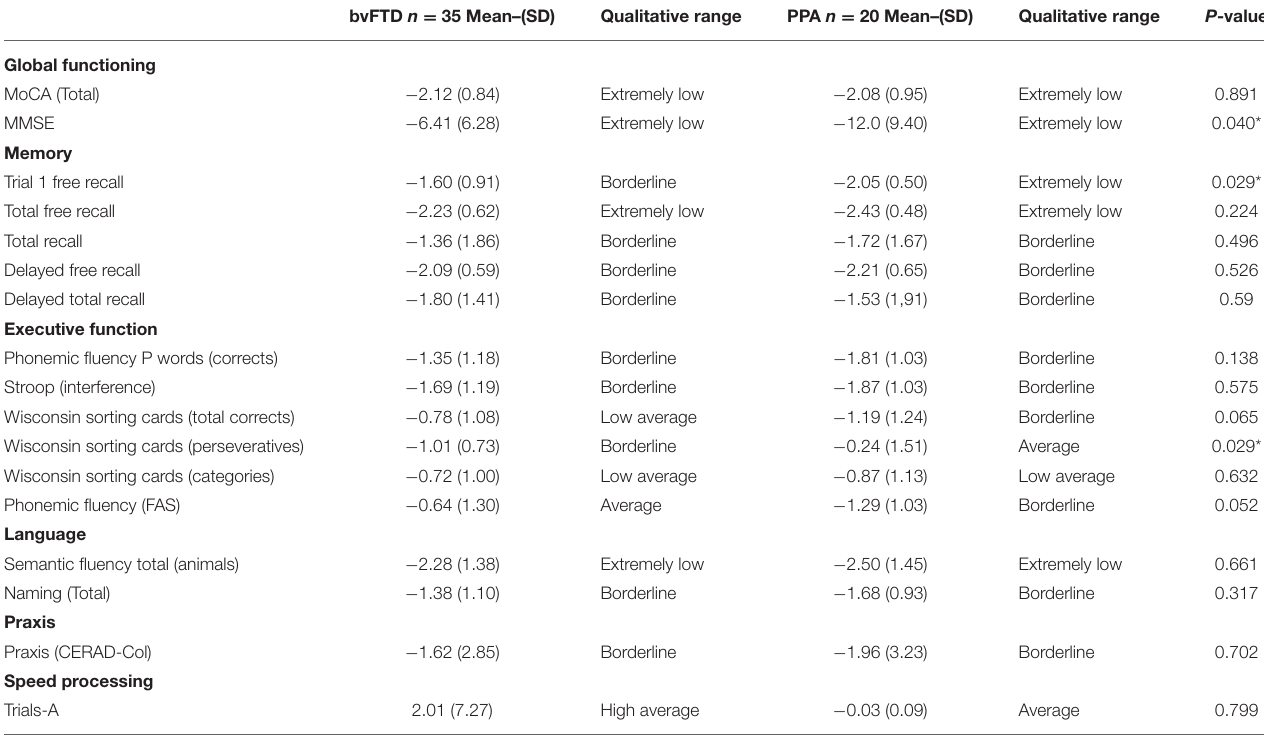
TABLE 2 | Neuropsychological profiles of bvFTD and PPA patients.